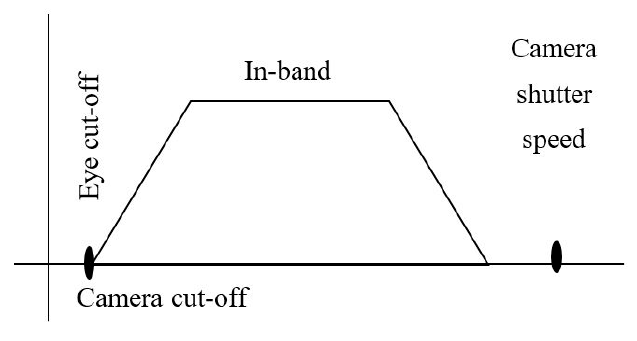
Figure 7. OCC frequency band.